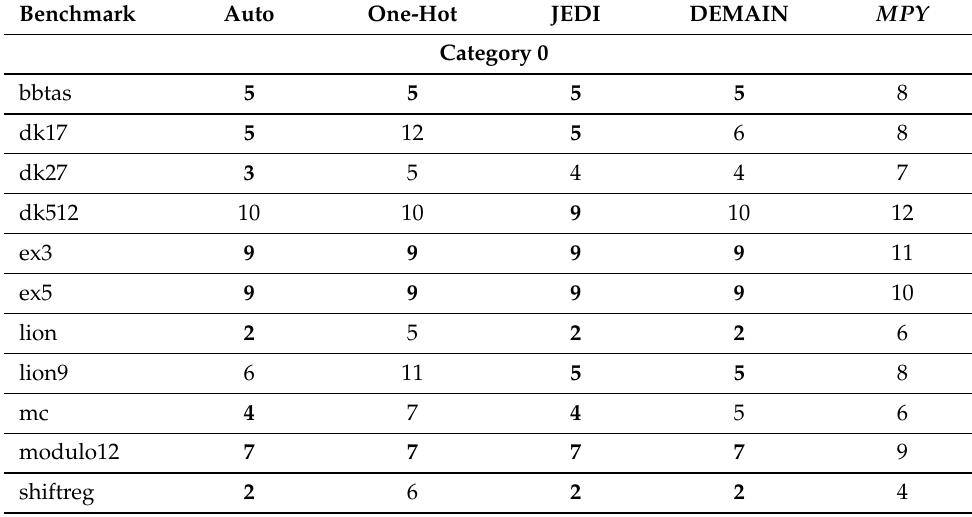
Table 11. Experimental results for MPY Mealy FSMs [123] (LUT